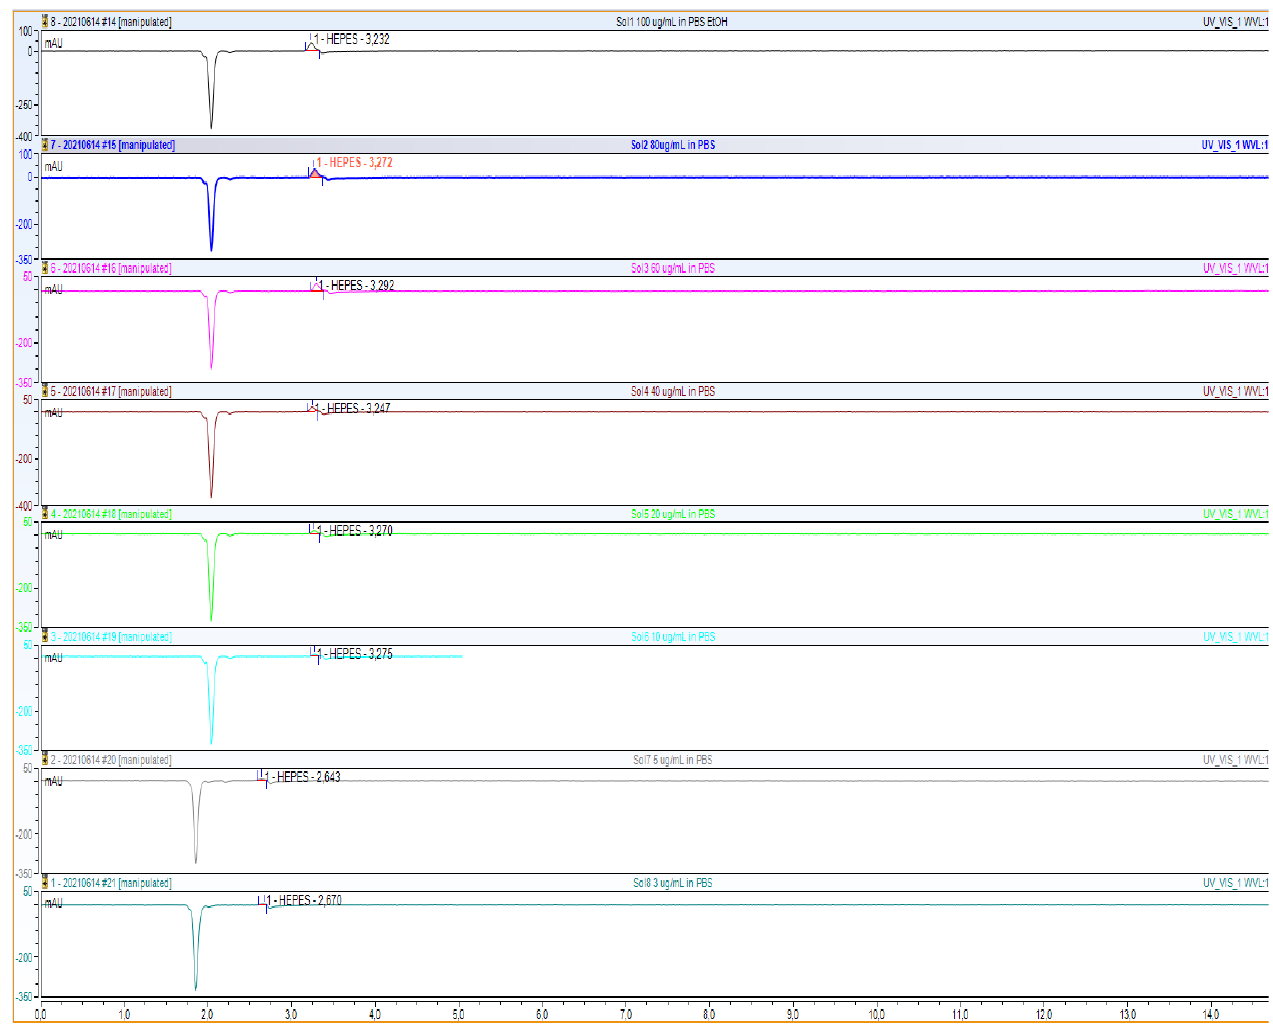
Figure 2. Overlay of the HPLC chromatograms of the analyzed HEPES solutions (100, 80, 60, 40, 20, 10, 5, 3 ug/mL).